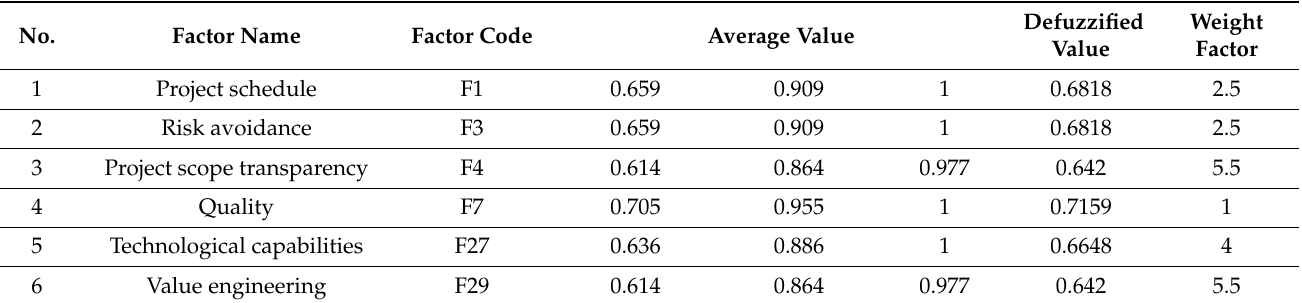
Table 3. Key selection